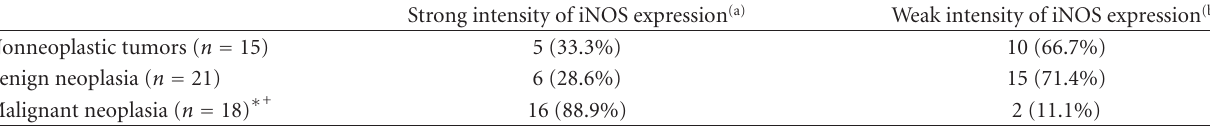
Table 2: Immunohistochemical staining of iNOS in nonneoplastic, benign, and malignant ovarian tissue samples. Strong intensity of iNOS expression (a) Weak intensity of iNOS expression (b) Nonneoplastic tumors ( n =